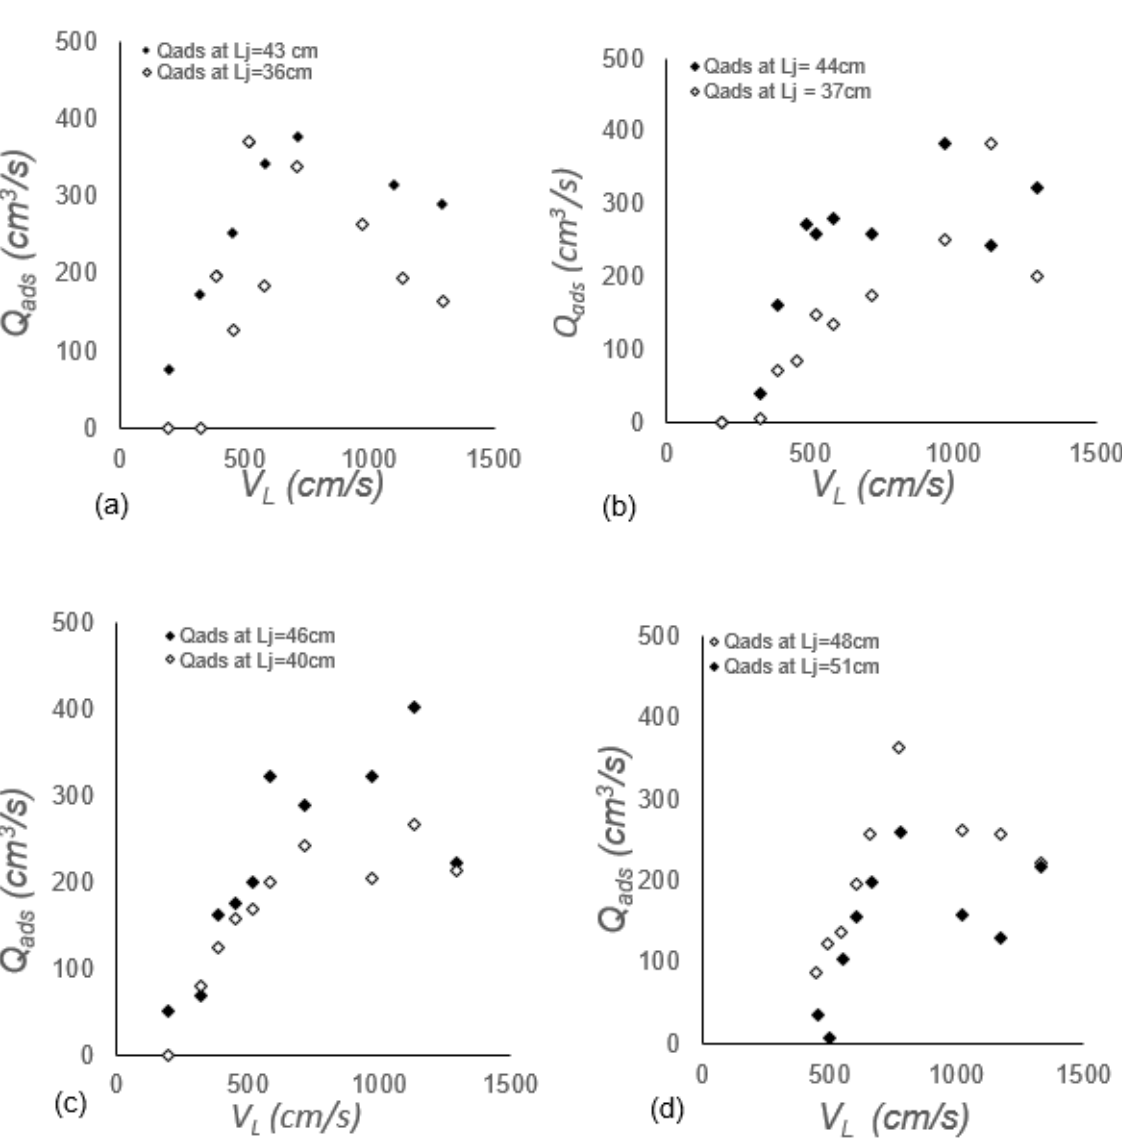
Figure 10. Disentrainment rates over wide range of V j and L j = 36–51 cm for d s = ( a ) 0 cm, ( b ) 1 cm, ( c ) 3 cm and ( d ) 5 cm.